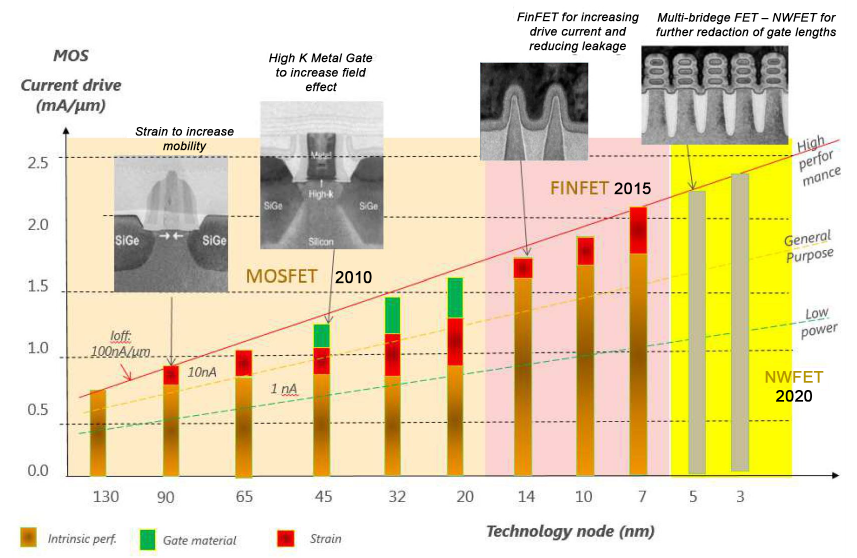
Figure 2. Retrospective review of logic MOSFET structures scaling. The ratio of drive current I on to leakage current I of f is steady increased for each more advanced transistor